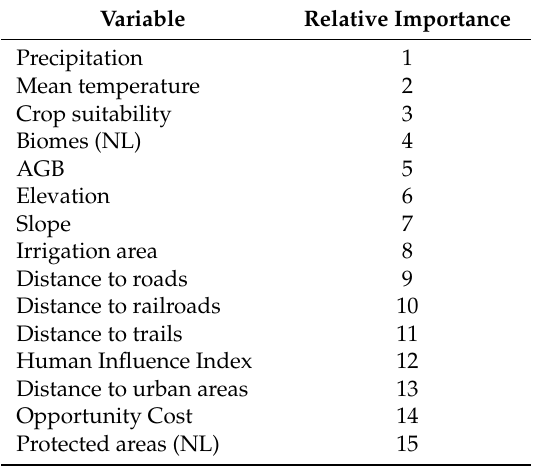
Table 2. Variable results for the global analysis, ranked by relative importance to the model